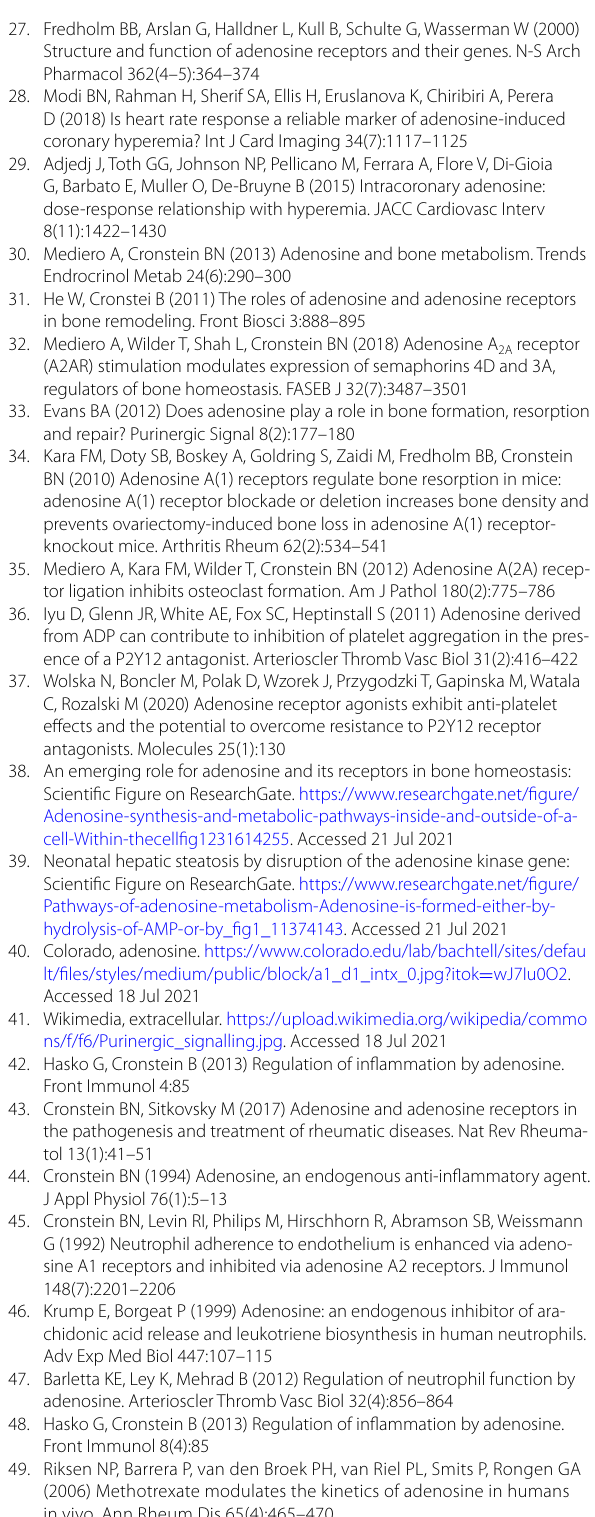
Scientific Figure on ResearchGate. https:// www. resea rchga te. net/ figure/ Adeno sine- synth esis- and- metab olic- pathw ays- inside- and- outsi de- of-a-